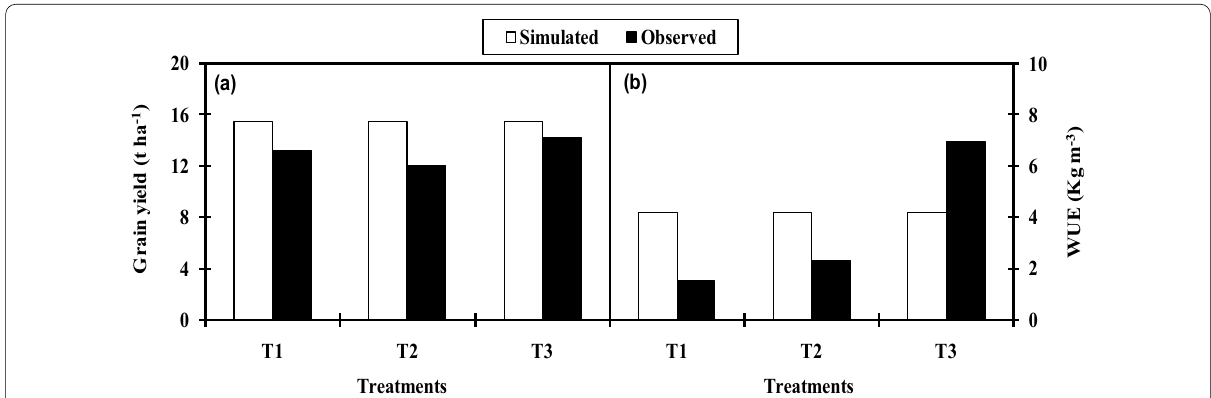
Fig. 4 a Grain yield and b water use efficiency (WUE) under different soil moisture regimes. T 1, T 2 and T 3 represent 30, 50 and 70% soil moisture depletion levels, respectively. The values are means